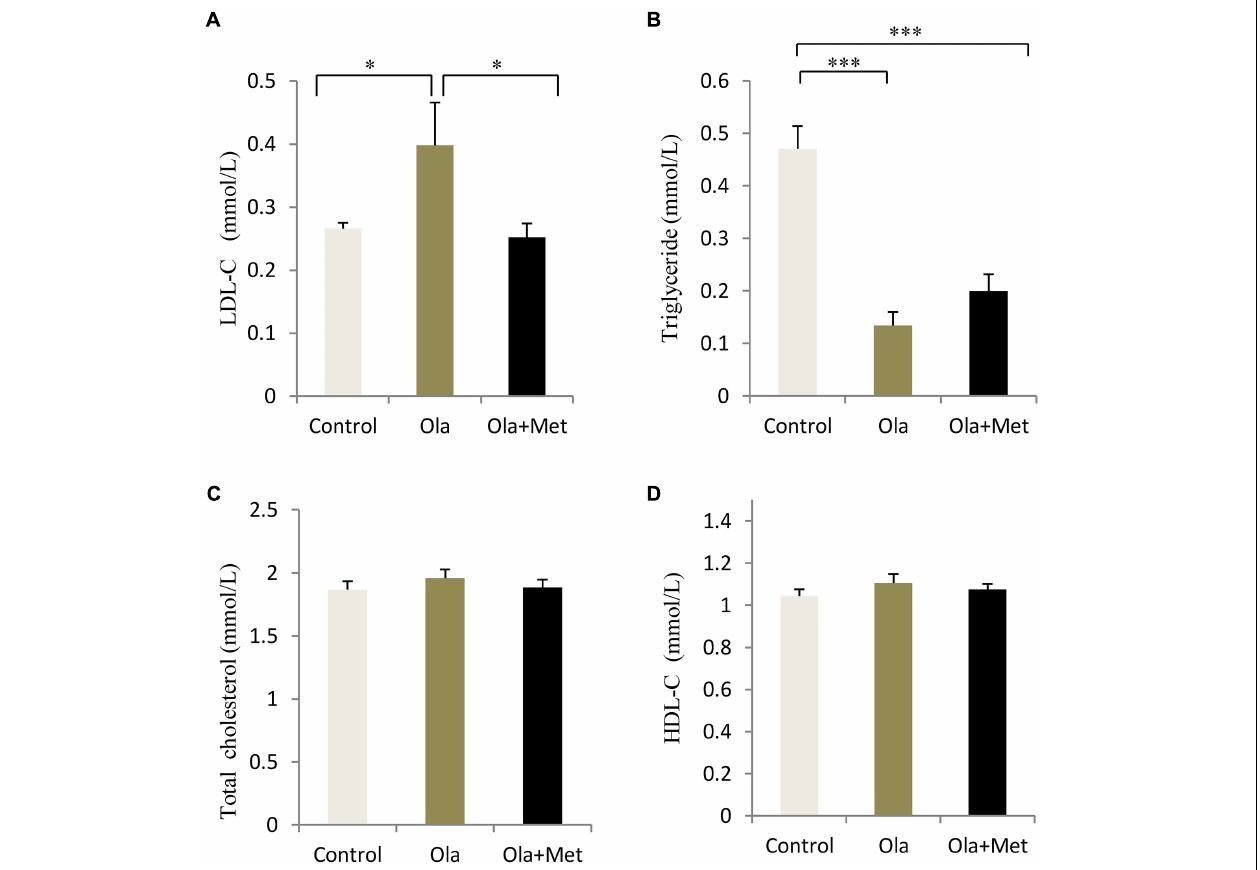
FIGURE 3 | Comparison of the blood lipid between different treatment groups in C57BL/6 mice. C57BL/6 mice were treated with olanzapine (4 mg/kg/day, Ola), olanzapine (4 mg/kg/day, Ola) + metformin (150 mg/kg/day, Met), or saline for 8 weeks. Effect of different treatment groups on LDL-C (A) , triglyceride (B) , total cholesterol (C) , and (D) , HDL-C at the end of 8-week treatment. All of the results are expressed as the mean ± SEM. ∗ p < 0.05, ∗∗∗ p <